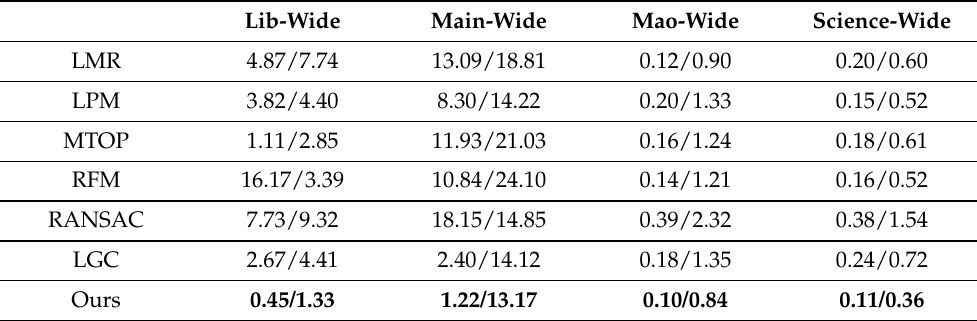
Table 7. The average rotation/translation angle errors ( ◦ ) on four scenes from the NMNET dataset. Smaller is better. The best results are in